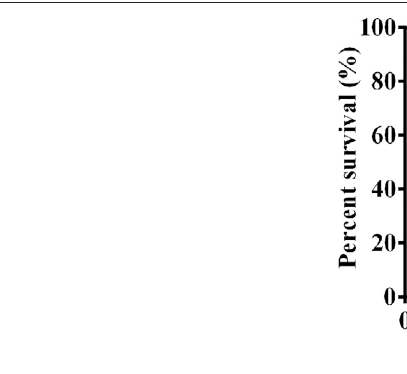
Frontiers in Pharmacology |